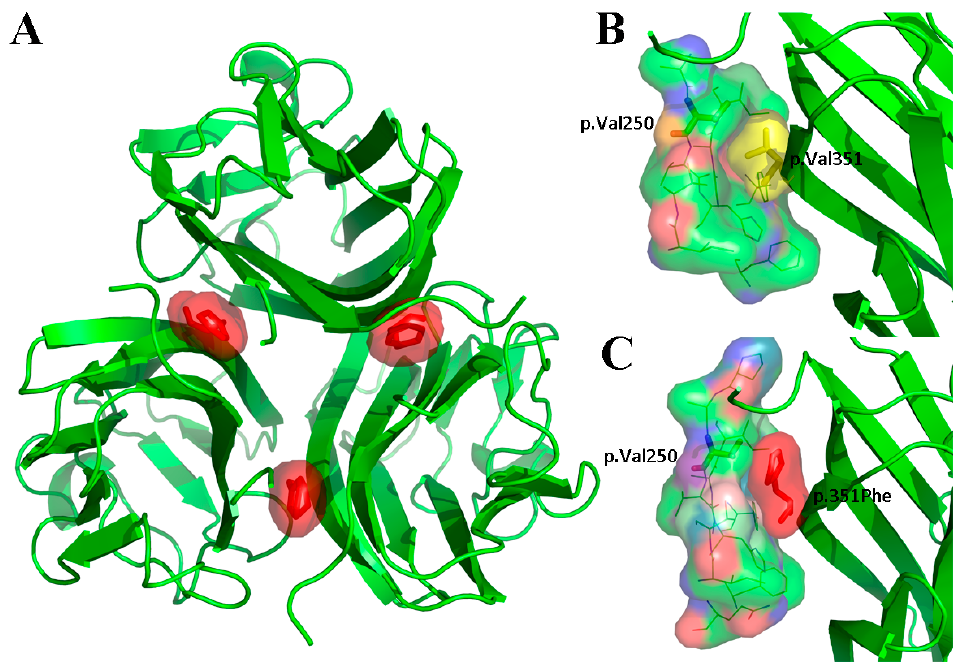
Figure 4. Structural modeling results of the Tumour Necrosis Factor (TNF) homology domain of p.Val351Phe-mutated ( A , C ) and wild-type ( B ) Ectodysplasin A (EDA) proteins. ( A ) The p.Val351Phe mutation was located on the monomer–monomer interaction surface of the three monomers. ( B ) In the wild-type EDA protein, there was a small gap between p.Val351 and p.Val250 of the adjacent monomer. ( C ) In the p.Val351Phe-mutated EDA protein, the mutated p.351Phe was too large and extruded with p.Val250 of the adjacent monomer.